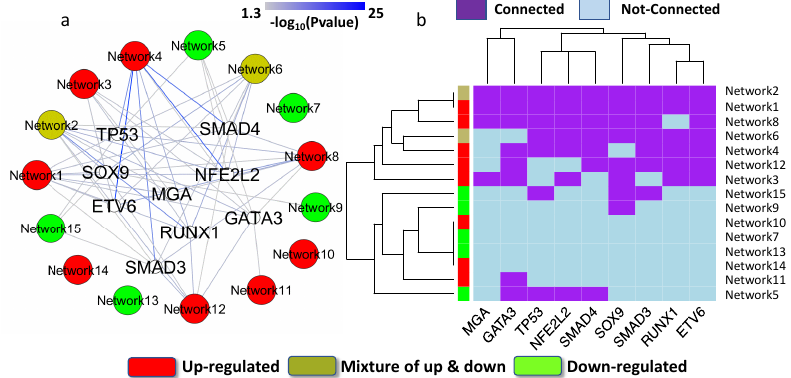
Figure 3. Key transcription factors outside the network. ( a ) The target genes of nine transcription factors that carried driver mutations were abundant in the regulatory networks. The color of the edge represents the p -value of the target gene enrichment analysis. The red-colored networks were over-expressed, whereas the green-colored networks were under-expressed in the disease. The yellow-colored networks were mixed with over-expressed and under-expressed genes. ( b ) The hierarchy clusters for the nine TFs and their regulated